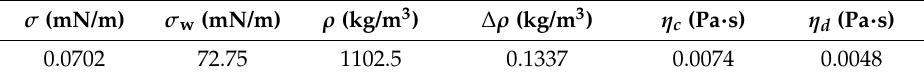
Table 4. Material data for the calculation of phase separation rate.